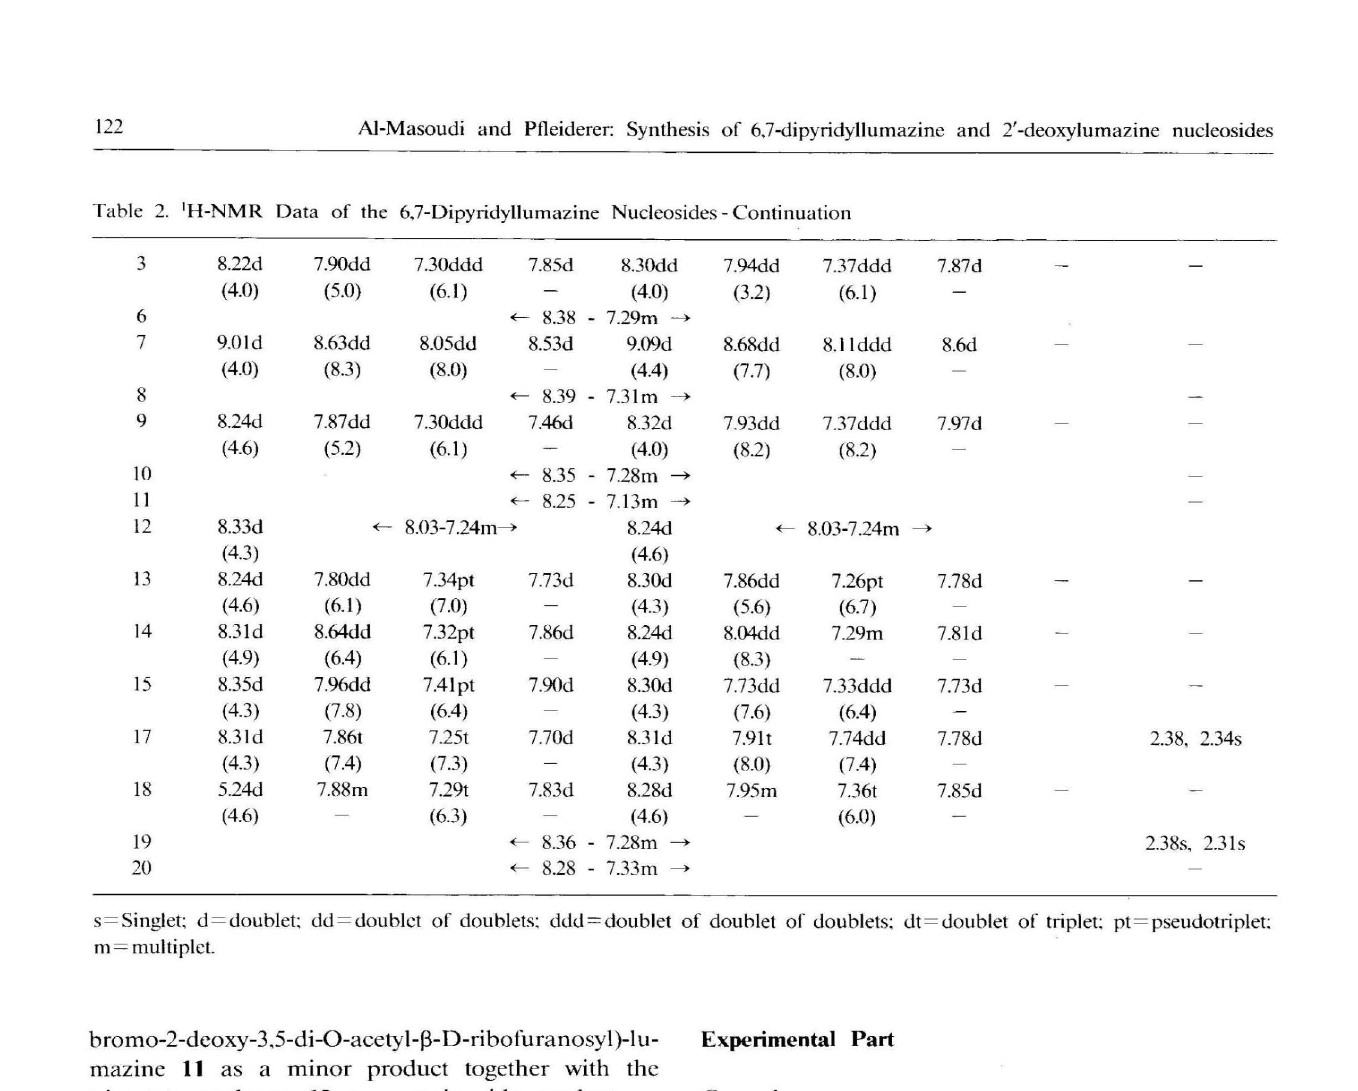
Table 2. IH-NMR Data of the 6,7-Dipyridyllumazine Nucleosides - Continuation